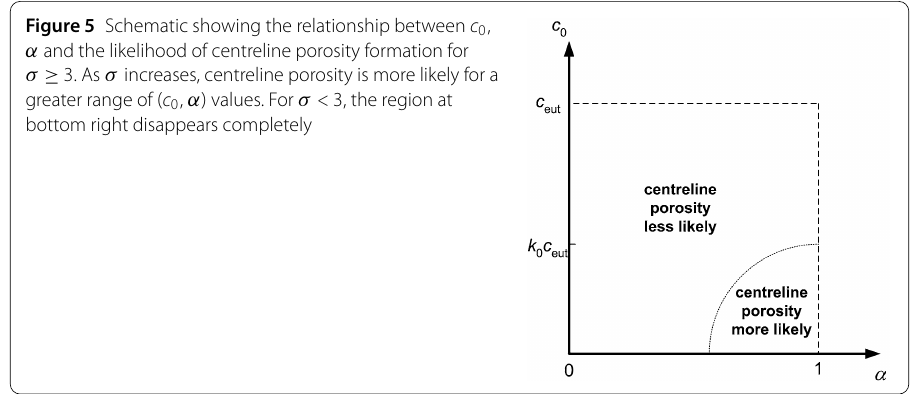
Figure 5 Schematic showing the relationship between c 0 , α and the likelihood of centreline porosity formation for σ ≥ 3. As σ increases, centreline porosity is more likely for a greater range of ( c 0 , α ) values. For σ < 3, the region at bottom right disappears